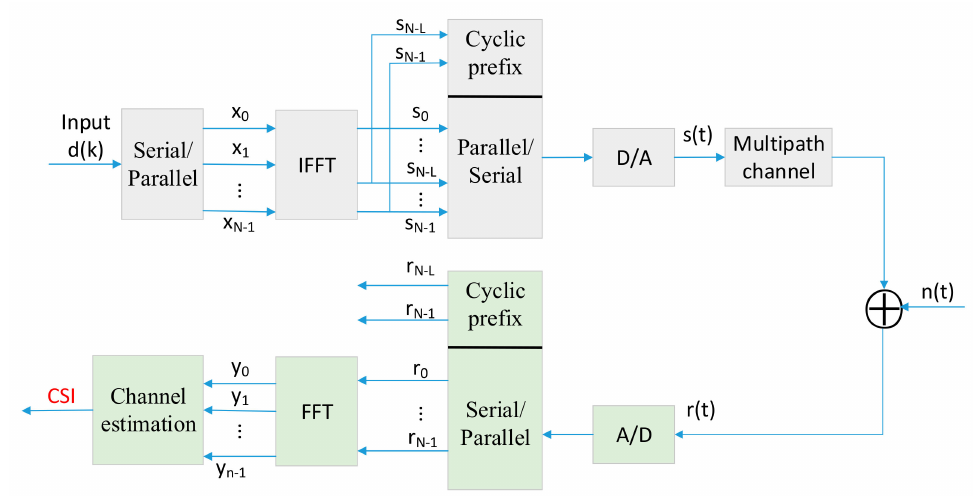
Figure 2. Block diagram of microwave sensing platform (MSP) to obtain channel state information (CSI)